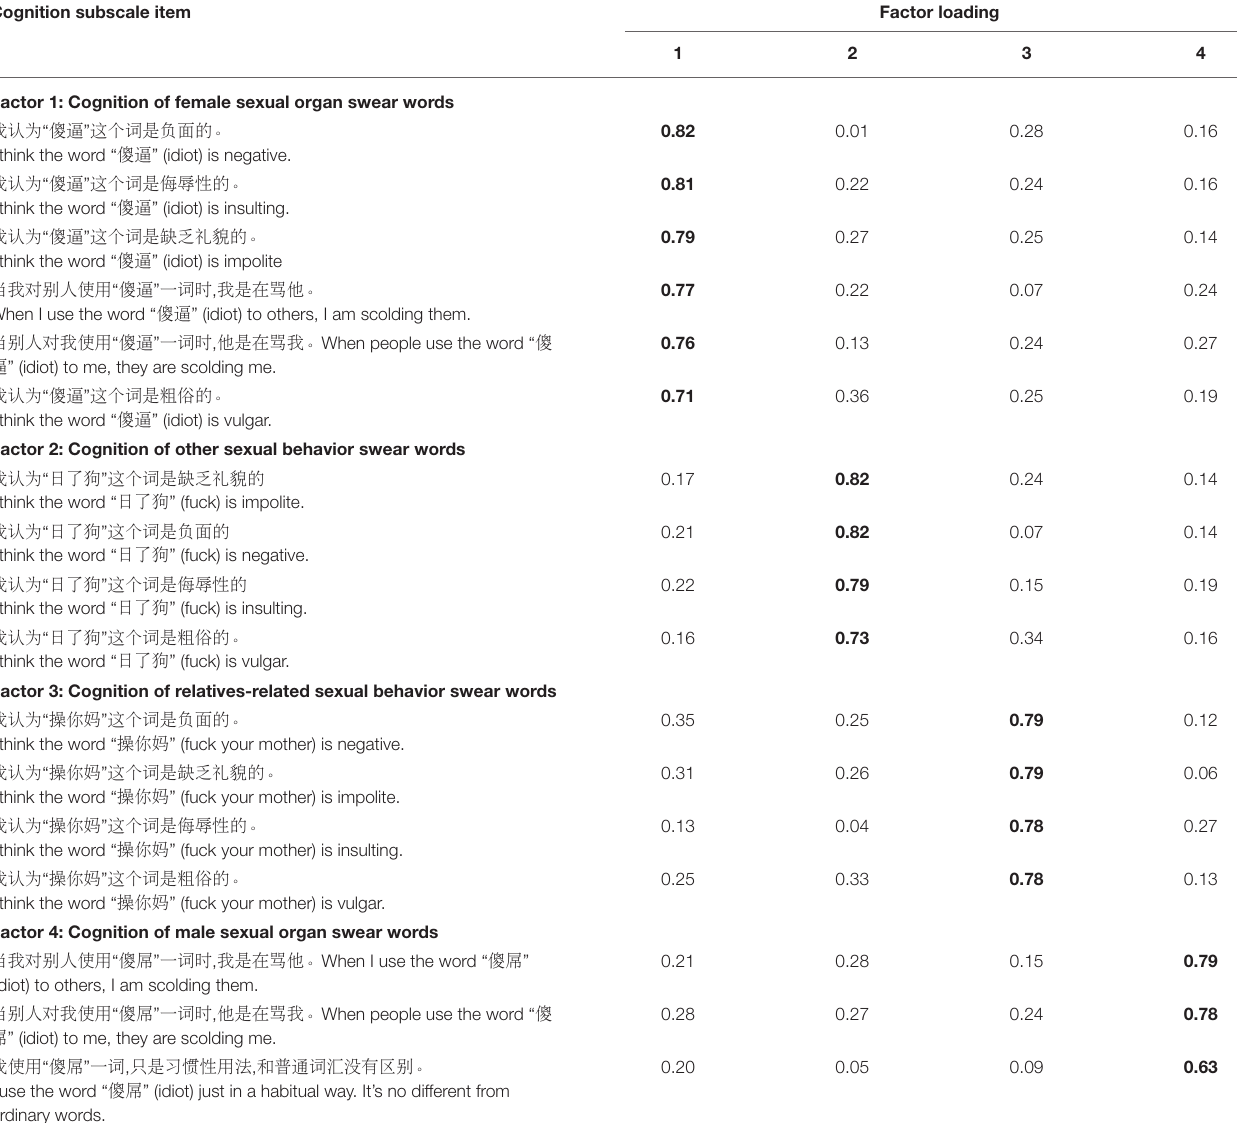
TABLE 2 | Exploratory factor analysis results of Cognition subscale. Cognition subscale